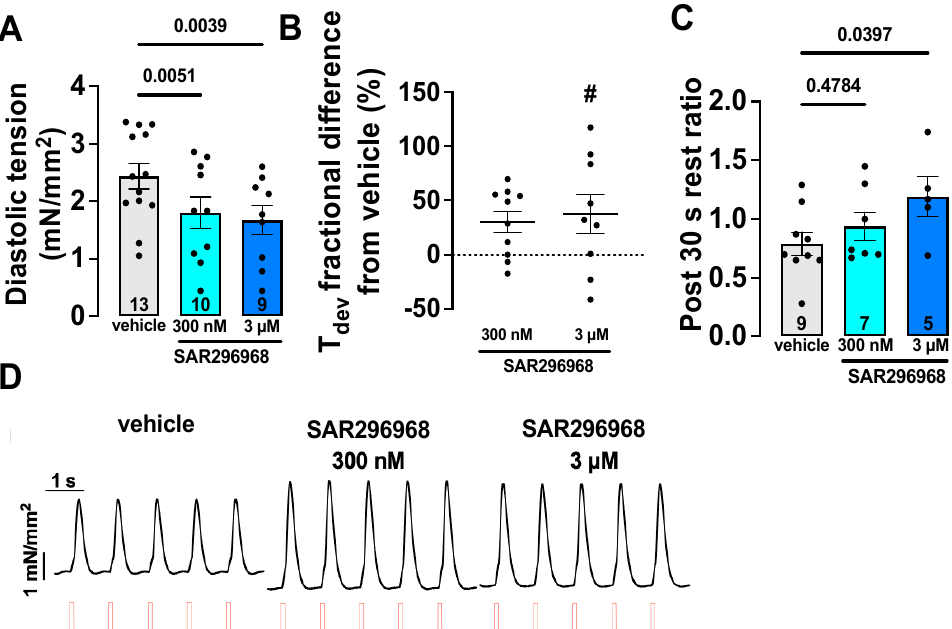
Figure 2. The numbers indicated are the numbers of patients. The data points represent individual patients. Each data point was calculated as the mean from several trabeculae within each patient. The mean data per patient shown for isolated human atrial trabeculae in steady-state (1 Hz) exposed to SAR296968. The diastolic tension is reduced by SAR296968 ( A ). The fractional difference in the developed tension compared to the vehicle was significantly increased ( B ), # indicates a significant difference from zero). Developed tension after 30 s rest (post-rest test) was significantly increased by SAR296968 at 3 µM ( C ). The original traces are shown in ( D ). The p -values are denoted above the corresponding groups, RM-mixed effects analysis with Bonferroni post-hoc test.